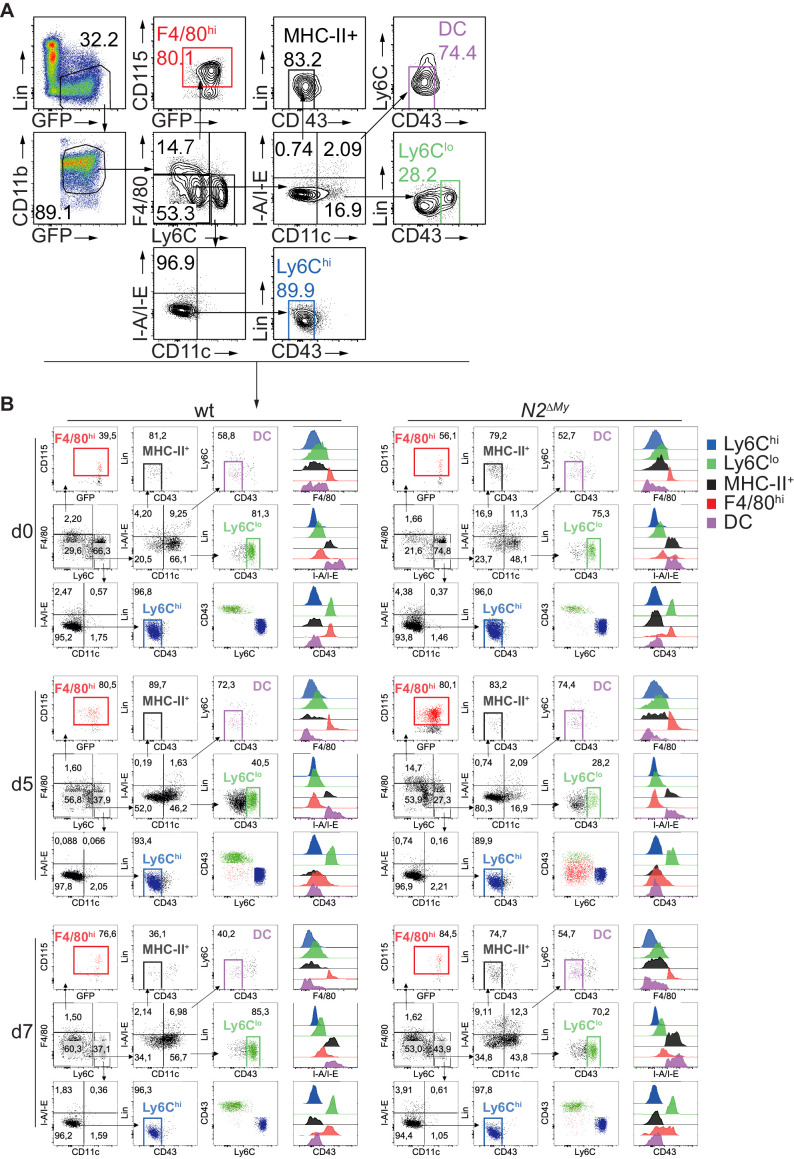
Identification of myeloid cell subsets in IMQ-treated mice.(A) Gating strategy for definition and quantification of myeloid subsets from live CD45+Lin-CD11b+GFP+ cells by flow cytometry. Defined populations are color-coded and used for subsequent quantification. (B) Representative gating of color-coded myeloid subsets in mouse peripheral blood for each experimental condition corresponding to Figure 3. Overlay dot plots show CD43 vs Ly6C expression in Ly6Chi, Ly6Clo or FM+ monocytes. Histograms show intensity of F4/80, CD43 and I-A/I-E for all defined populations.